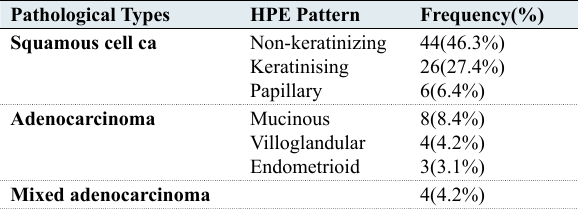
Table 2: Histopathological pattern of cervical malignancies